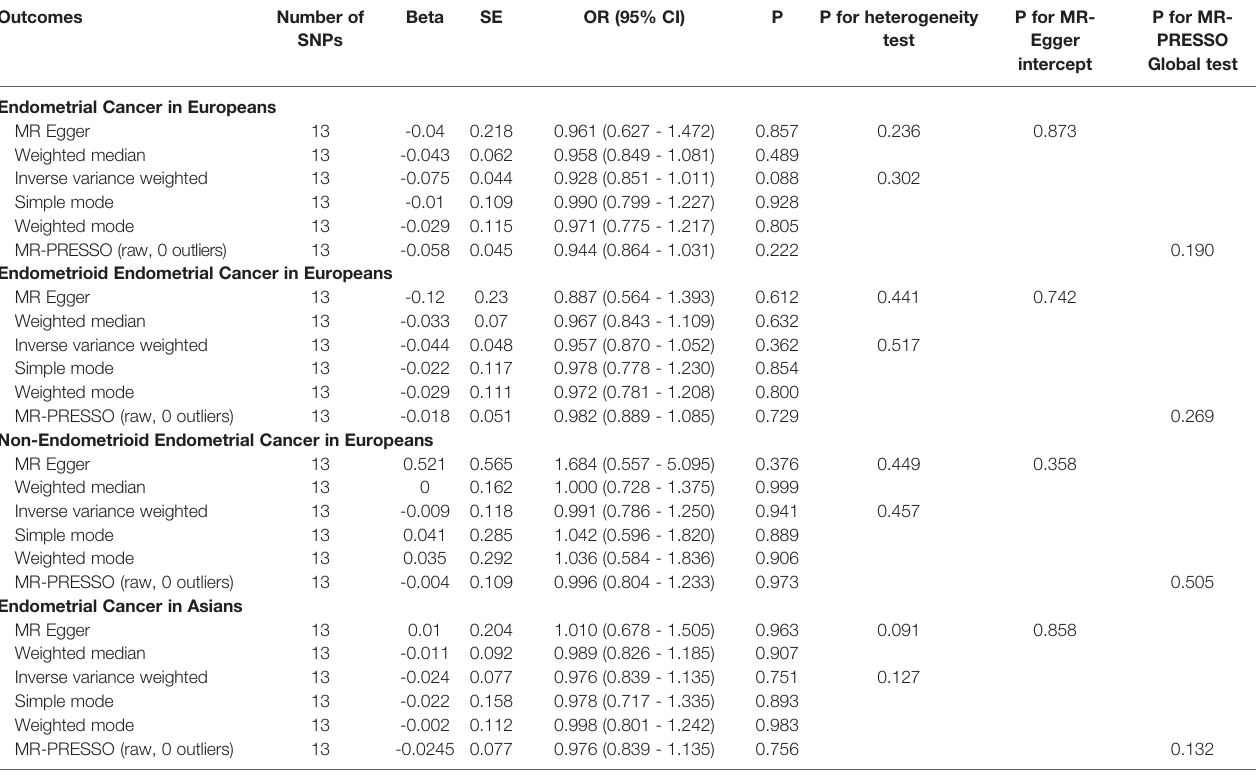
TABLE 3 | Associations between genetically predicted PCOS and endometrial cancer in Asians and Europeans using MR-Egger, weighted median, inverse variance weighted, simple mode, weighted mode and MR-PRESSO methods. Outcomes Number of